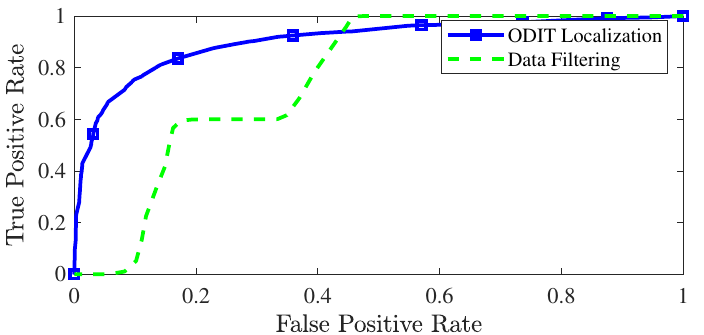
Figure 7. ROC curve of ODIT and the conventional data filtering approach for identifying anomalous dimensions in the change-in-the-mean